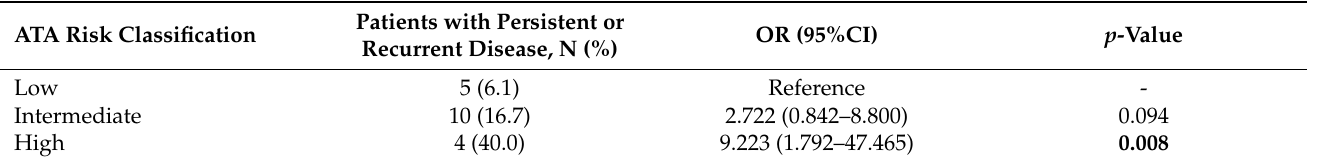
Table 3. Relative risk of persistence or relapse of disease at last follow-up as per initial ATA risk classification.